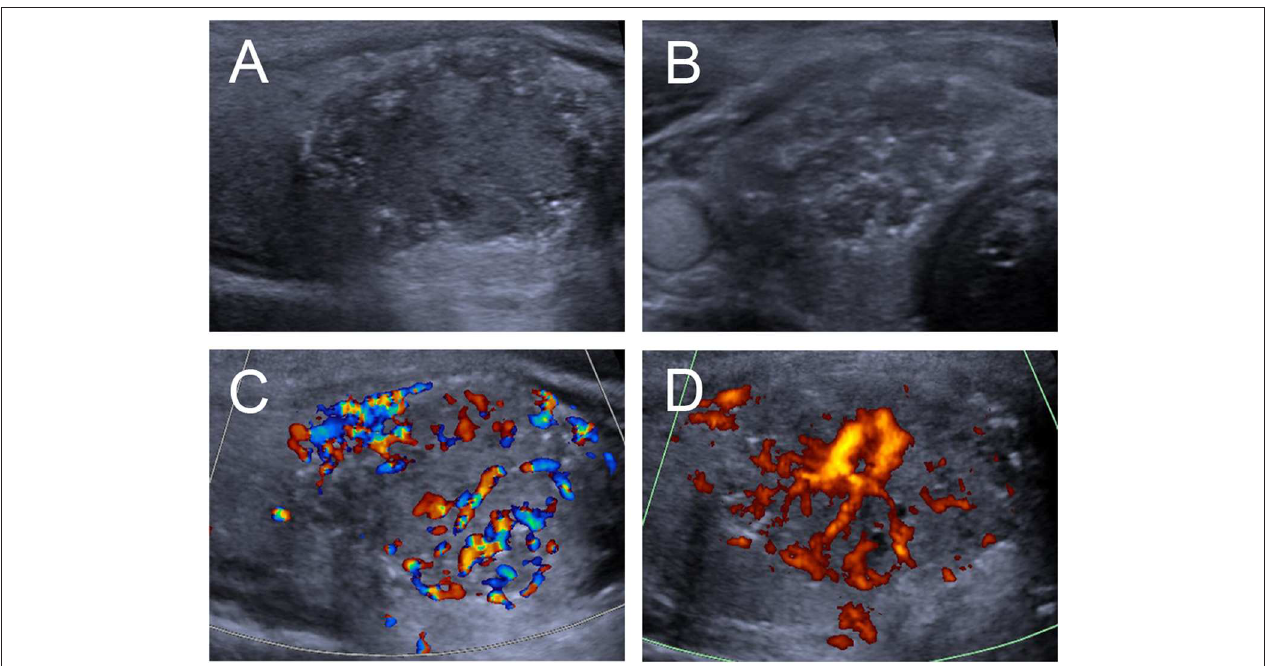
FIGURE 2 | Ultrasound images of an 18-y-old female PTC patient with petal-like calcification of the right thyroid lobe. (A) Longitudinal and (B) Horizontal gray-scale sonograms; the thyroid nodules had a solid component, hypoechoic echogenicity, and ill-defined margin. (C) Color Doppler and (D) Energy Dopper sonograms showed abundant internal and peripheral